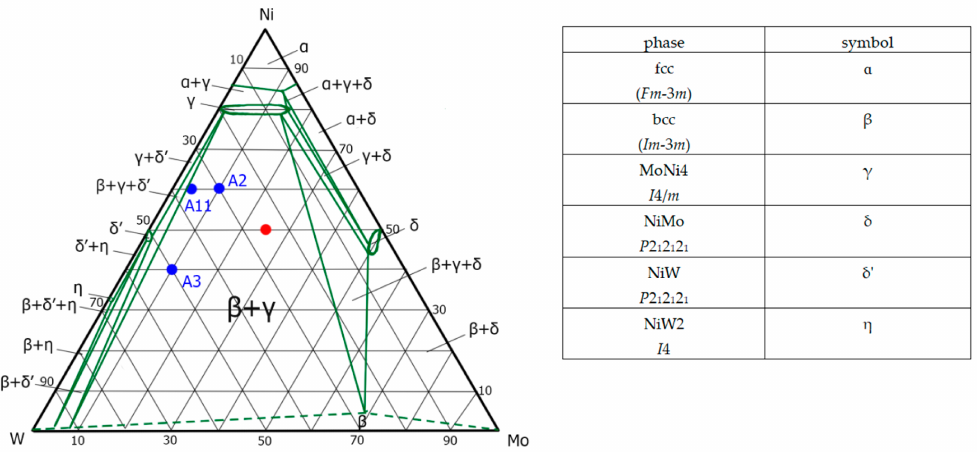
Figure 4. Ternary W–Mo–Ni (1000 ◦ C isothermal cross-section). The red circle highlights the area of the initial atoms’ ratio Ni/Mo/W studied in this work; the blue circles highlight the areas of the initial metal ratio of the samples from [44].